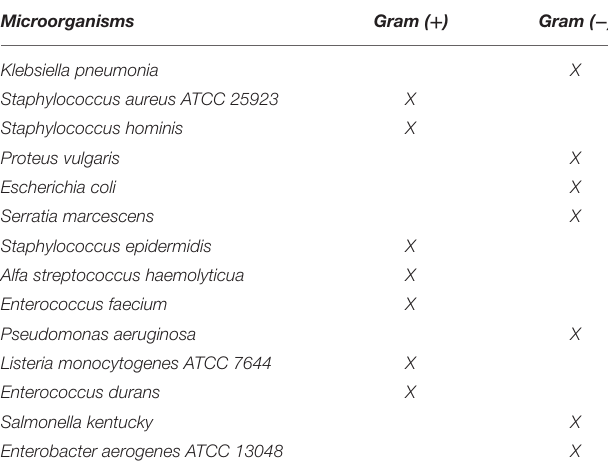
TABLE 2 | Microorganisms used for antimicrobial activity